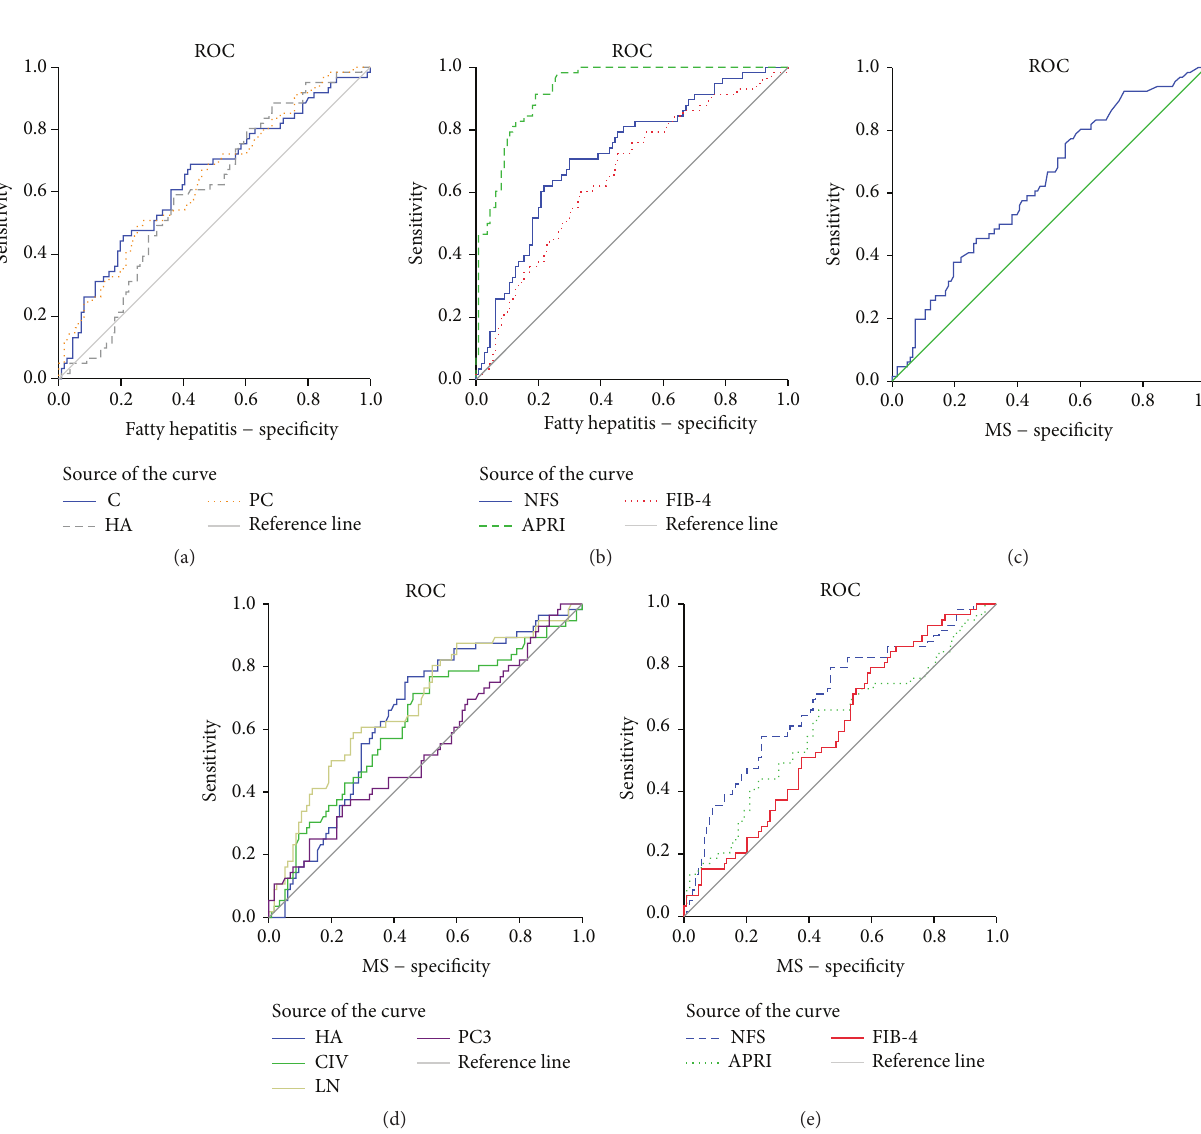
Figure 2: ROC in NASH and MS. In NASH, (a) CIV: area under the receiver operating curve (AUROC) = 0.641, 𝑃 = 0.002 ; HA: AUROC = 0.597, 𝑃 = 0.035 ; PCIII: AUROC = 0.638, 𝑃 = 0.003 ; (b) NFS: AUROC = 0.722, 𝑃 = 0.041 ; APRI: AUROC = 0.930, 𝑃 = 0.0318 ; FIB-4: AUROC = 0.653, 𝑃 = 0.044 . In MS, (c) IHF had an AUROC of 0.639 with 𝑃 = 0.003 ; (d) CIV: AUROC = 0.62, 𝑃 = 0.01 ; LN: AUROC = 0.679, 𝑃 < 0.001 ; HA: AUROC = 0.64, 𝑃 = 0.002 ; PCIII: AUROC = 0.543, 𝑃 = 0.36 ; (e) NFS: AUROC = 0.690, 𝑃 = 0.043 ; APRI: AUROC = 0.601, 𝑃 = 0.047 ; FIB-4: AUROC = 0.589, 𝑃 = 0.045